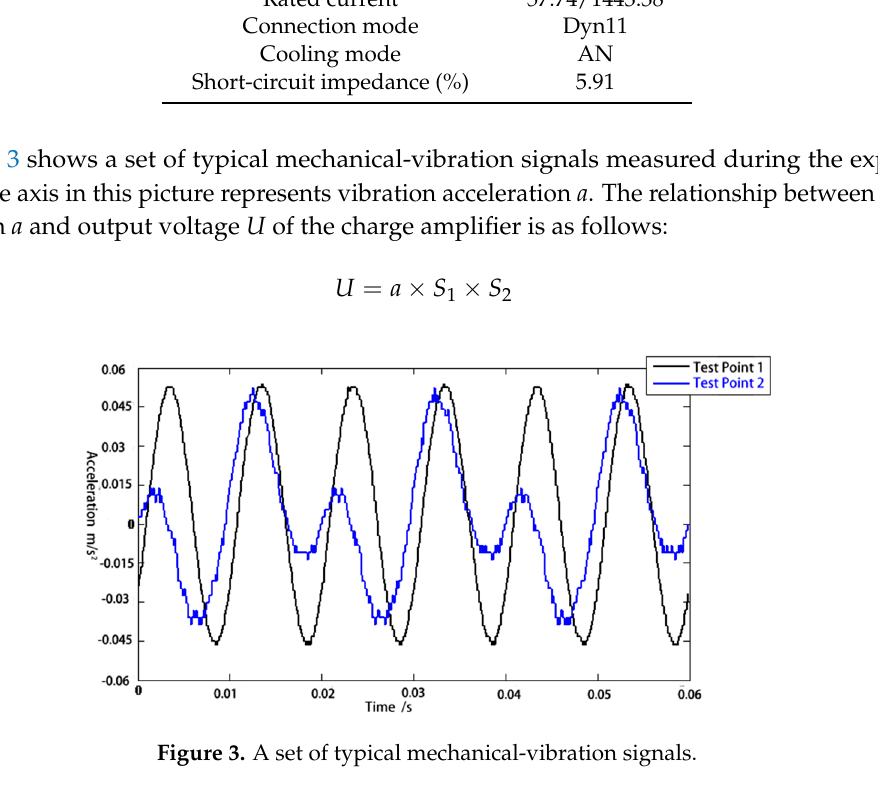
Figure 3. A set of typical mechanical-vibration signals.